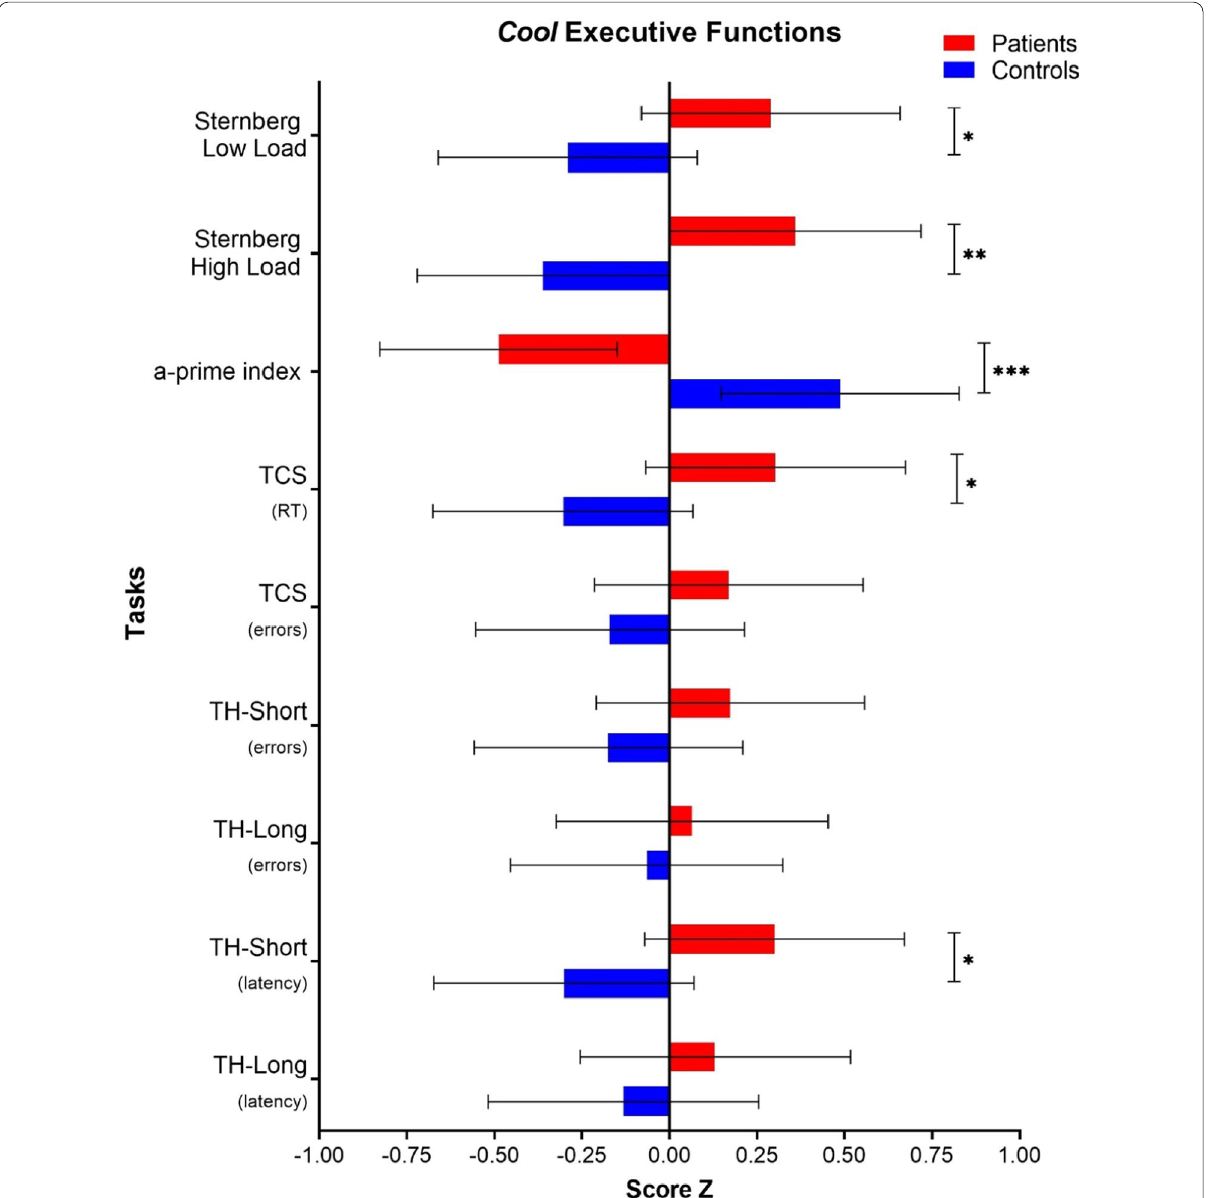
Fig. 2 Cool EEFF compared between patients and controls. Note : TSC